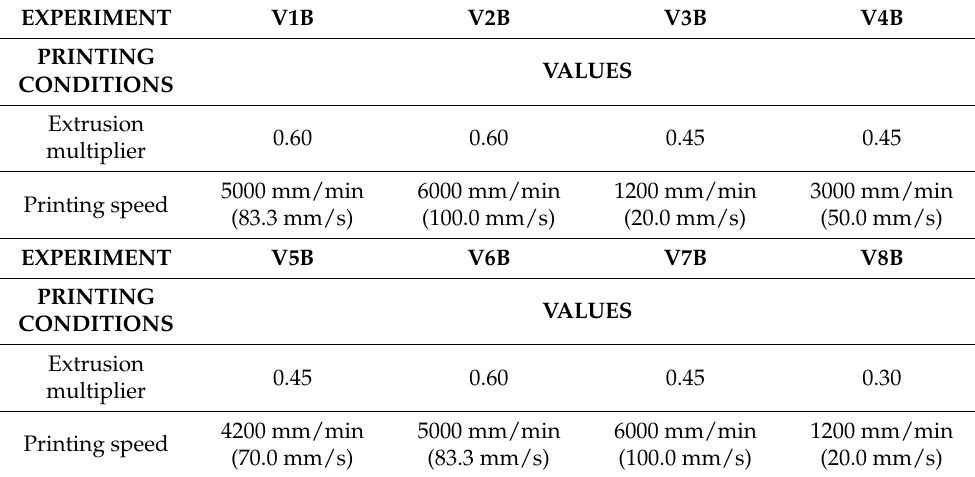
Table 4. Printing parameters of experiments